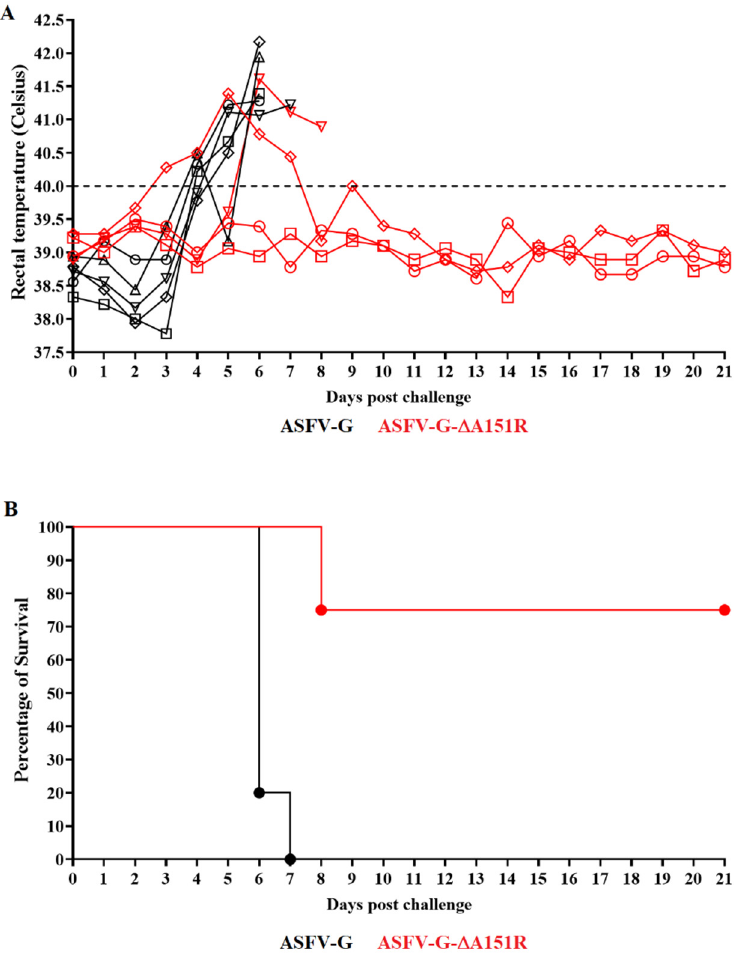
Figure 8. Evolution of body temperature ( A ) and mortality ( B ) in animals (4 animals/group) IM infected with 10 2 HAD 50 of ASFV-G- ∆ A151R and challenged 28 days later with 10 2 HAD 50 of paren- tal ASFV-G.